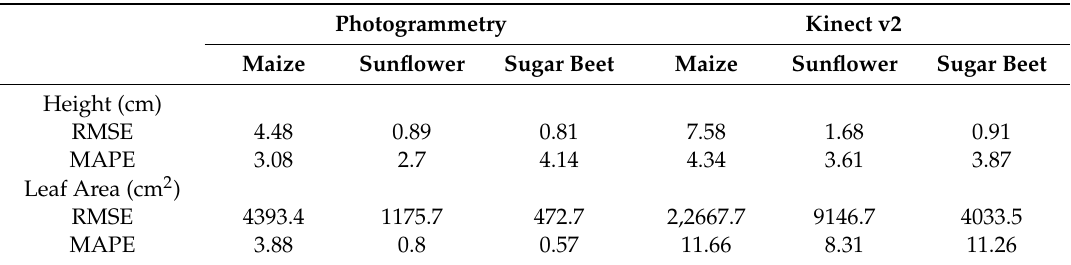
Figure 4. Regression analyses comparing actual leaf area versus estimated leaf area using 3D modeling methods. Table 2. Root mean square error (RMSE) and mean absolute percentage error (MAPE) calculated values for photogrammetry and Kinect v2 methods in three di ff erent